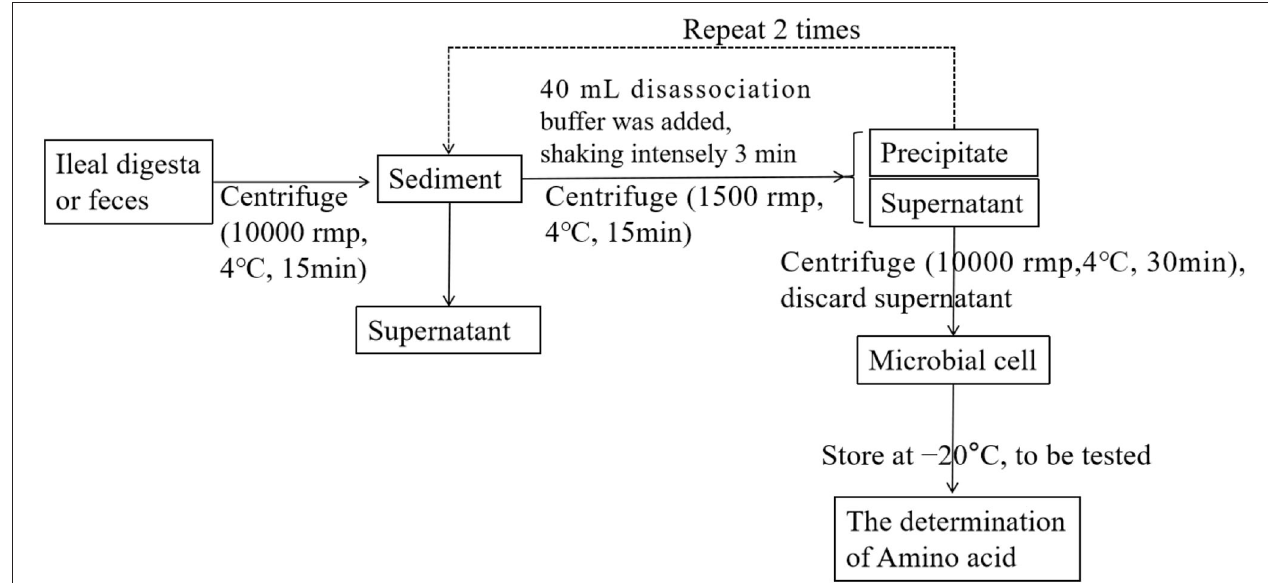
FIGURE 1 | Schematic diagram of the processing of the digesta samples.